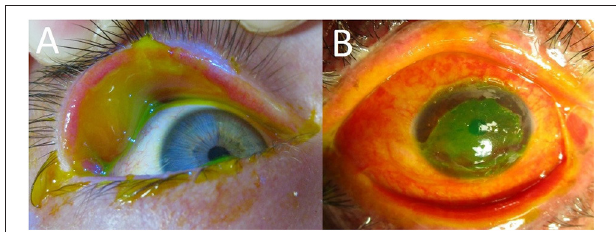
FIGURE 1 | (A) Fluorescein staining in an acute SJS patient showing extensive palpebral conjunctival sloughing despite limited bulbar conjunctival sloughing. (B) Severe eye involvement in an acute SJS patient (extensive sloughing of the corneal epithelium, bulbar conjunctiva, palpebral conjunctiva, and lid